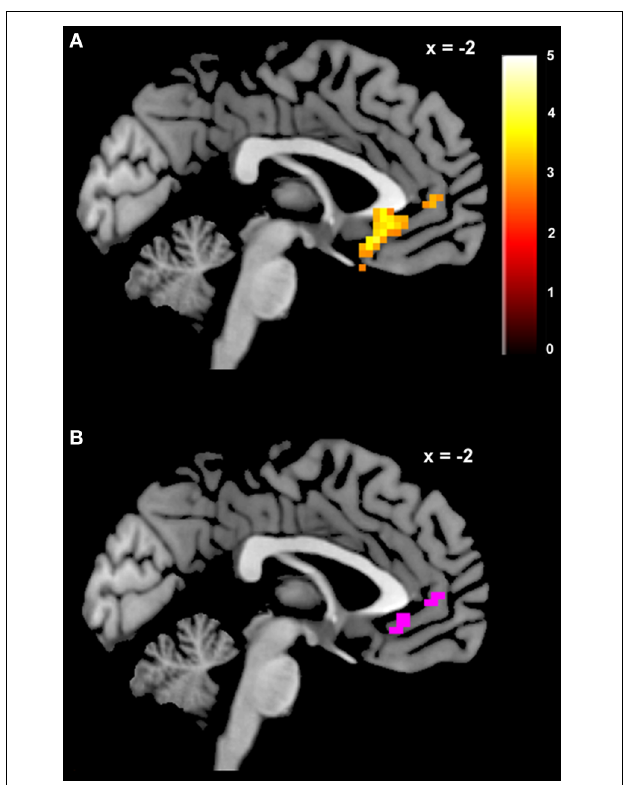
FIGURE 3 | Areas correlated with the rdSV regressor from GLM-rdSV. (A) A region of vmPFC showing increased activity as a function of rdSV ( p < 0 . 05 SVC). (B) Voxels in vmPFC where the activation for rdSV in the current study overlaps with significant voxels in meta-analyses of positive correlations with subjective value by Bartra et al. (2013) and Clithero and Rangel (2013). All voxels shown in violet are significant in all three studies.